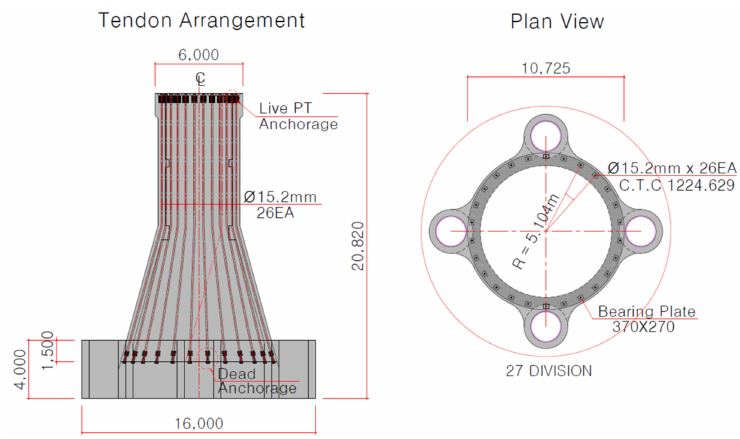
Figure 20. Arrangement of prestressed tendons.